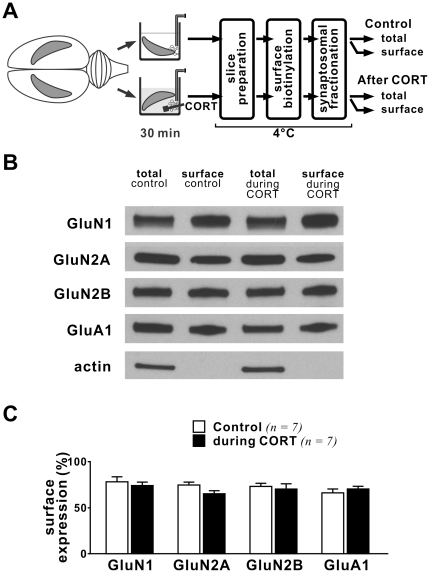
Trafficking of glutamate receptors in adult hippocampal synapses during CORT treatment.(A) Schematic diagram shows procedures for drug treatment and tissue labeling. The two hippocampi from each rat were either incubated with aCSF (control) or CORT (100 nM, 30 min). At the end of CORT treatment, these hippocampi were cut into slices and labeled as described in Methods. Note that all labeling and purification steps were performed at 4°C. Surface and total proteins from control and CORT-treated hippocampi of each rat were compared by western blotting. (B) Representative blots of different glutamate receptor subunits and actin in synaptosomal membranes from control and CORT-treated hippocampi of the same rat. (C) Histogram summarizes the surface expression of glutamate receptors (ratio of surface/total) in control and CORT-treated hippocampi. Note that the surface expression of glutamate receptors was not altered during CORT treatment.